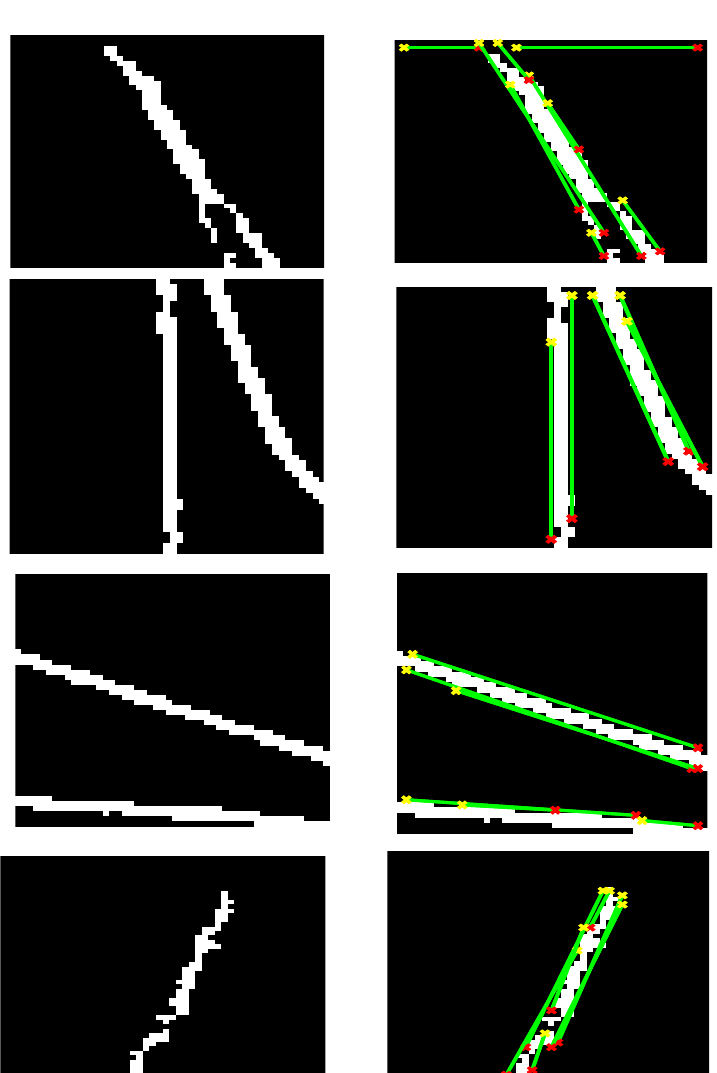
Figure 4. Sub-masks using Hough Transform at each block.